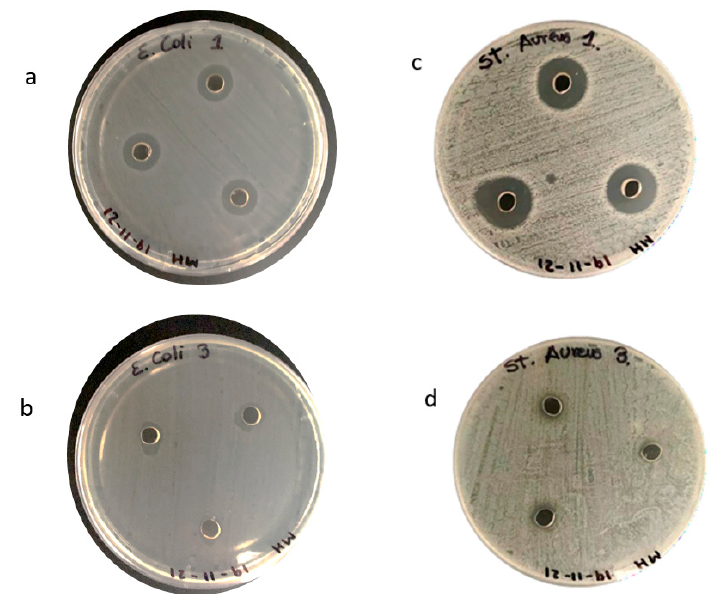
Figure 7. Antibacterial activity against Escherichia coli ATCC 33876 of AgNPs conjugated with the ethanolic fraction (EF) of Lepechinia meyenii (salvia) ( a ) and EF of Lepechinia meyenii (salvia) ( b ), and against Staphylococcus aureus ATCC 25923 of AgNPs conjugated with the ethanolic fraction (EF) of Lepechinia meyenii (salvia) ( c ) and EF of Lepechinia meyenii (salvia) ( d